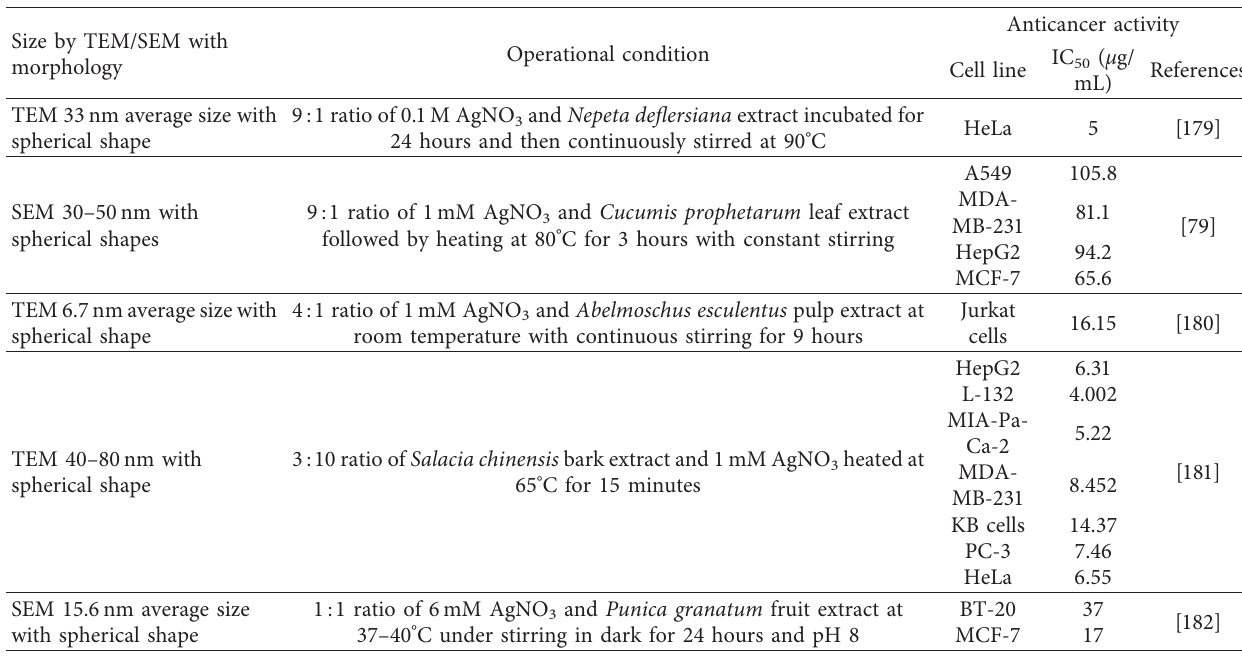
Table 7: Morphology of green synthesized Ag NPs and their pesticide activity on different species. Phytoconstituent present